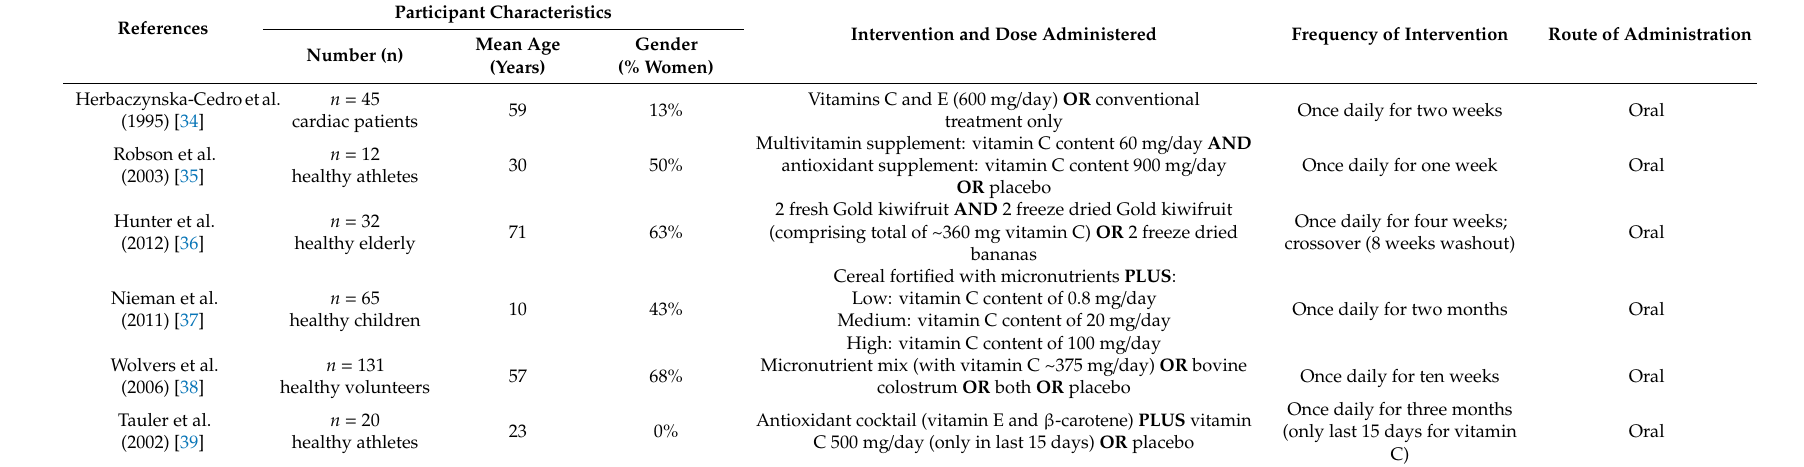
Table 3b. The participant characteristics and interventions used, the frequency of intervention and the route of administration for combination